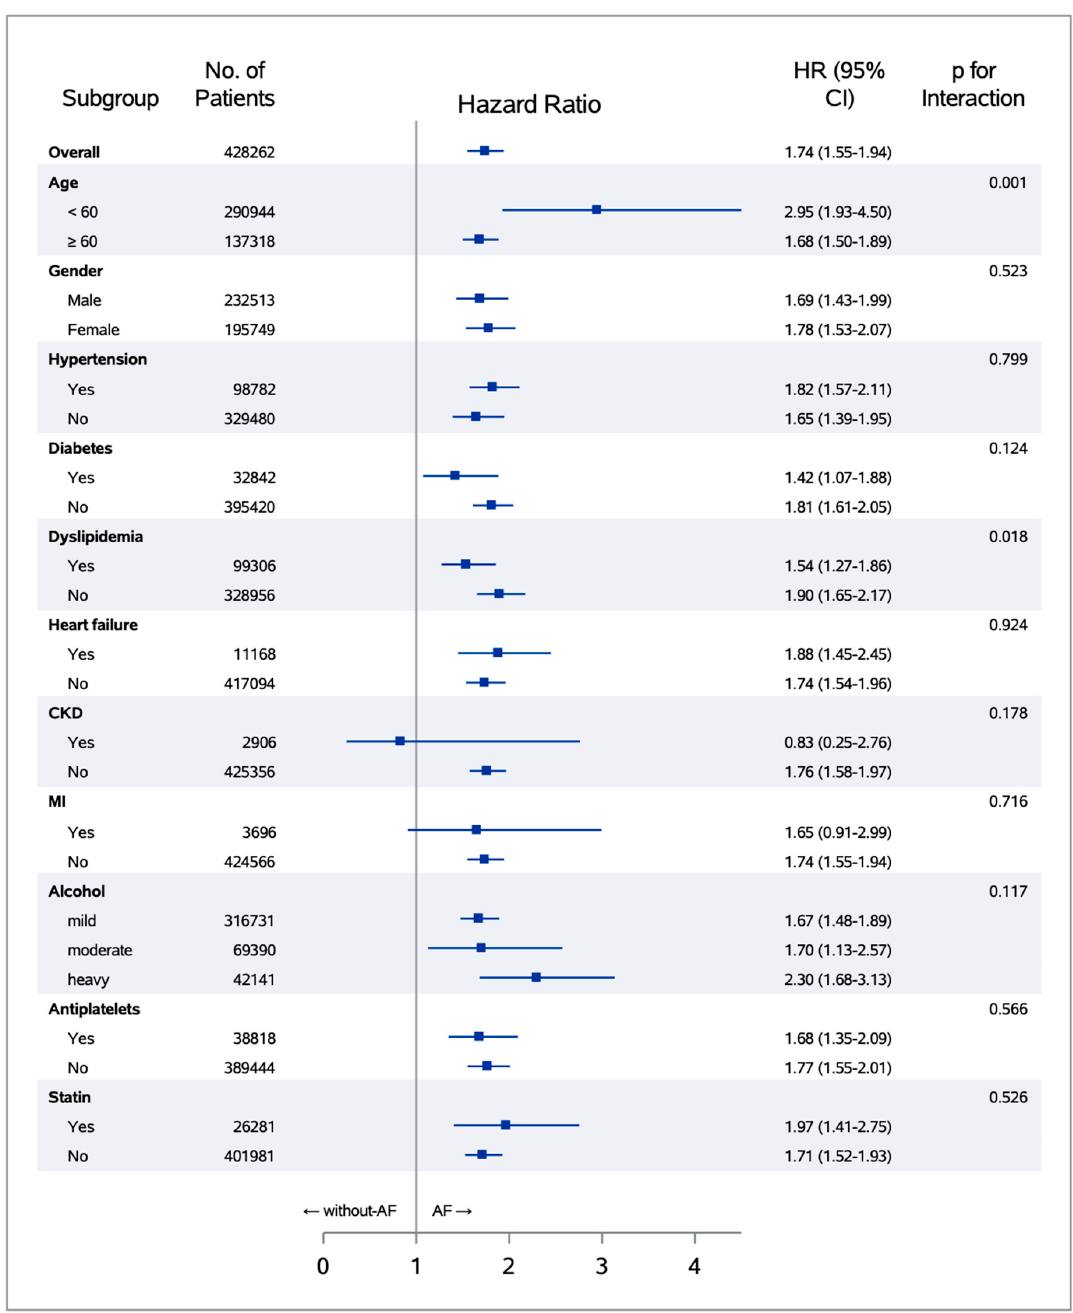
Figure 4. Subgroup analysis for the risk of dementia according to the AF status. The hazard ratios and the 95% confidence intervals are expressed as boxes and limit lines, respectively. The vertical line (at hazard ratio 1) indicates no difference in hazard ratios between AF and without-AF groups.